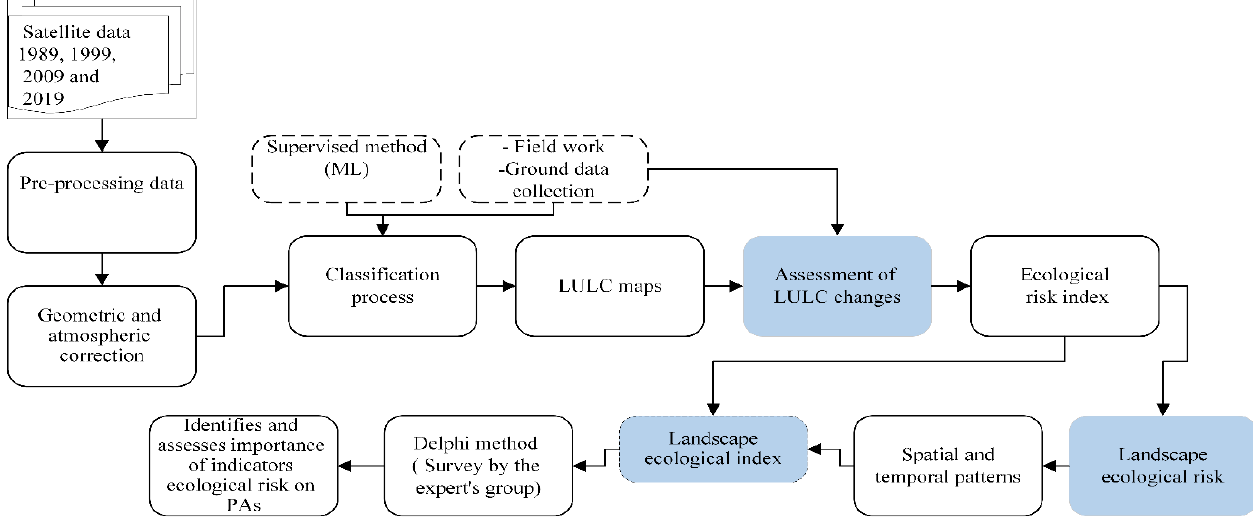
Figure 2. The process of the research.